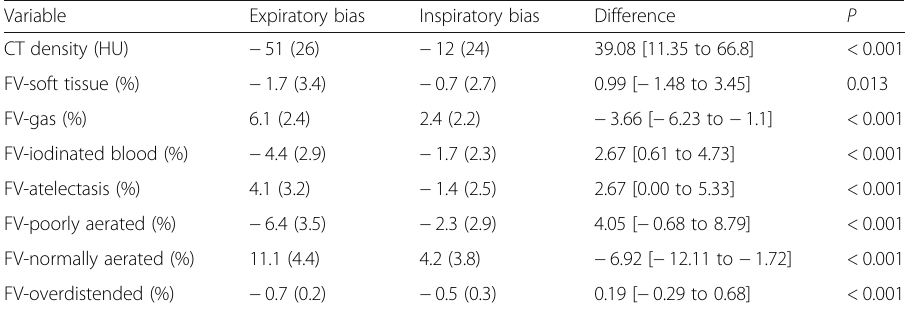
Table 3 Limits of variable bias due to inspiration between dCT and whole-lung means